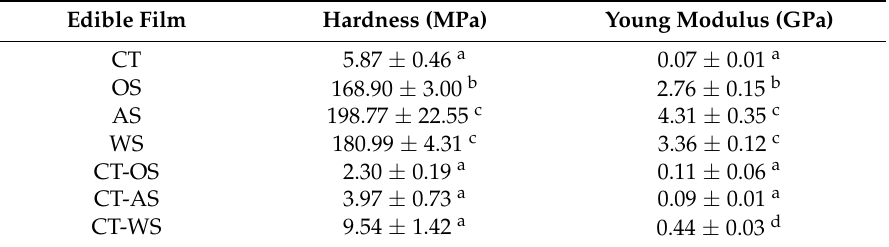
Table 3. Hardness and Young’s modulus of edible films based on starch, CH and CH-starches mixtures (1:3 ratio, w / w ).